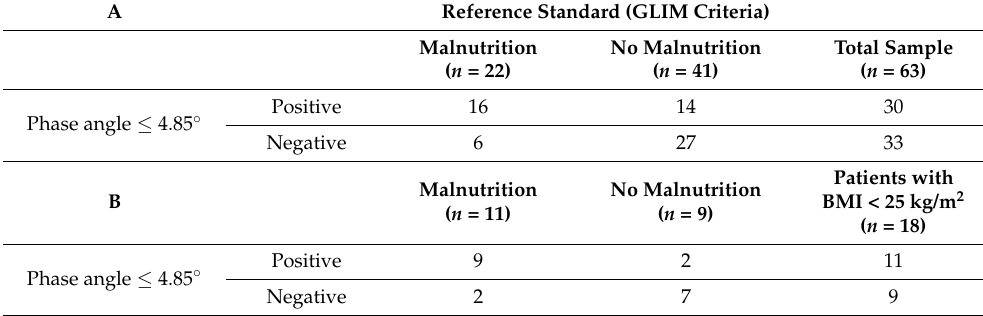
Figure 2. Receiver operating characteristic (ROC) curve for prediction of malnutrition based on the GLIM criteria. Table 2. Contingency tables showing the frequency distribution of the phase angle values (cutoff point ≤ 4.85 ◦ ) in candidates on the waiting list for kidney transplantation (A) and in the subgroup of patients with body mass index <25 kg/m 2